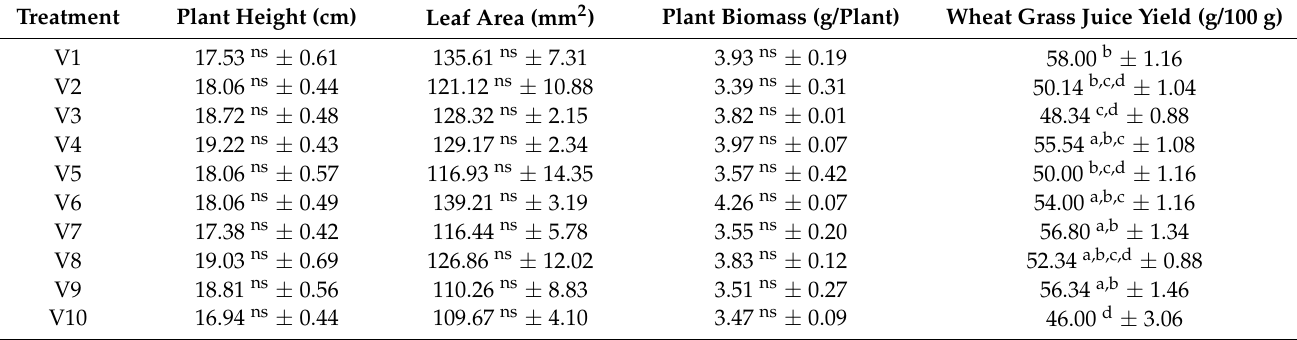
Table 2. Morphology of wheat grass and yield of wheat grass juice cultivated on pond